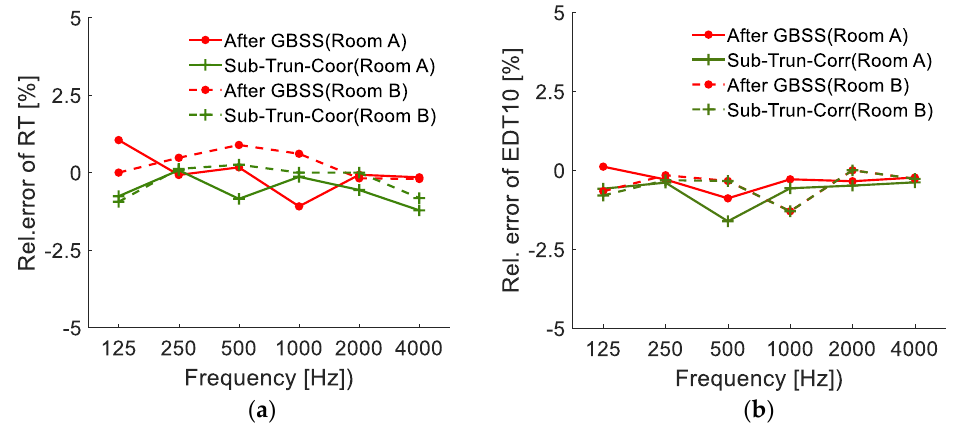
Figure 9. Comparison of the GBSS algorithm and the compensation method. ( a ) Reverberation time relative errors. ( b ) Early decay time relative errors.